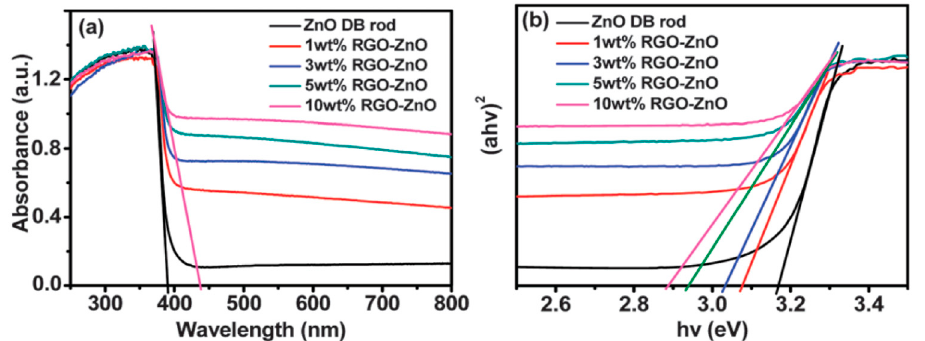
Figure 7. ( a ) UV-vis diffuse reflectance spectra, and ( b ) the plots of Kubelka–Munk function versus light energy for neat ZnO nanorod and RGO/ZnO nanocomposites. Reproduced from [172] with permission of the Royal Society of Chemistry.